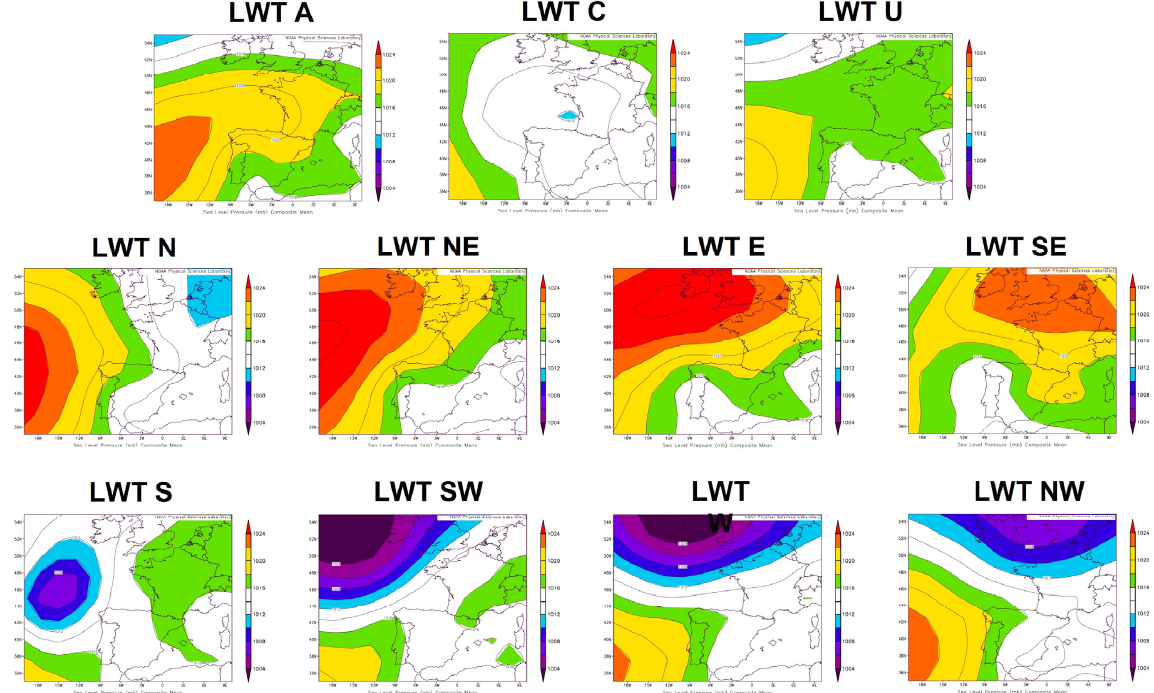
Figure C2. SLP fields characteristic of the ten basic summer (JA) CWTs. The contour interval is 2 hPa. Images provided by the NOAA/ESRL Physical Sciences Laboratory, Boulder Colorado from their Web site at http://psl.noaa.gov/ (accessed on 31 August 2021).